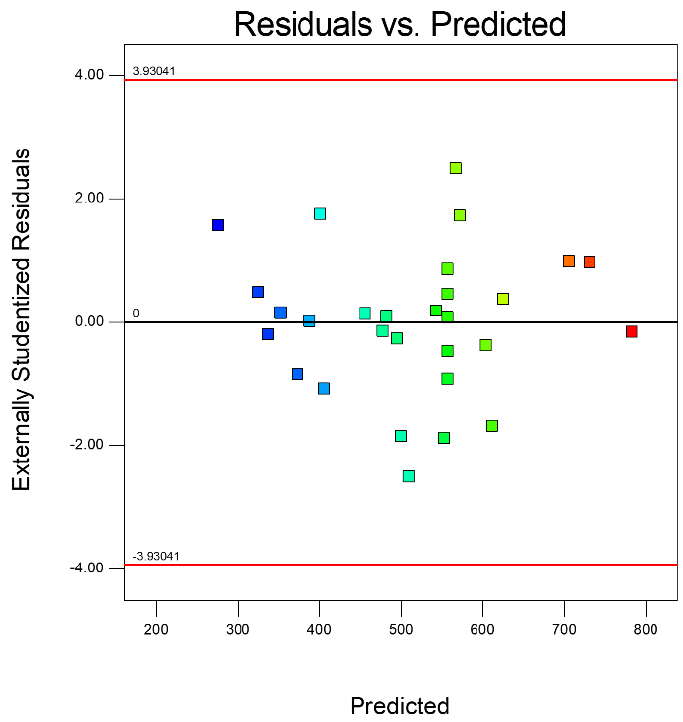
Figure 13. Normal plot of residuals.